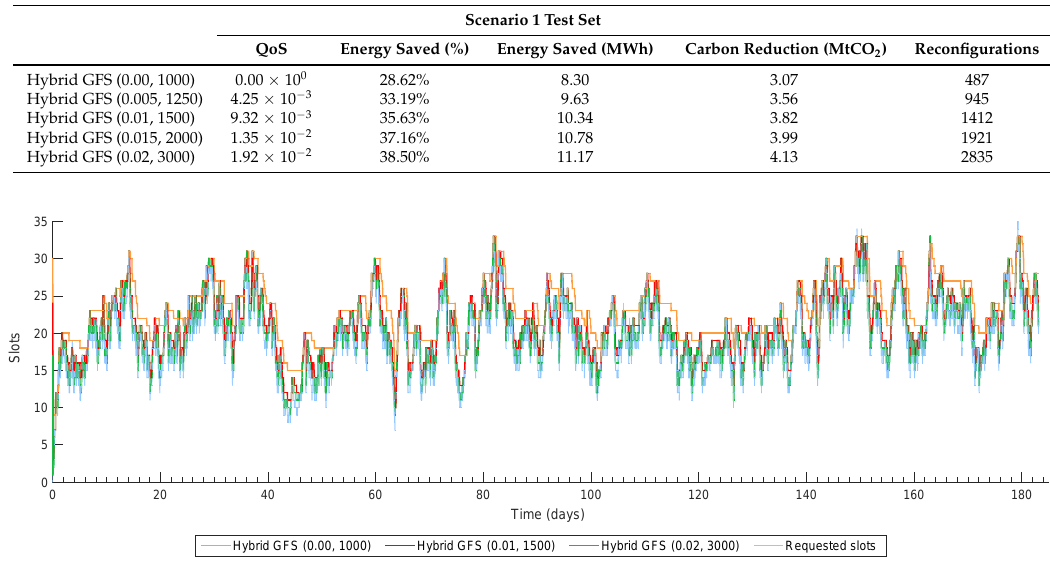
Figure 4. Cluster simulation trace for the test set of scenario 1. GFS: Genetic Fuzzy System. Table 3. Experiment results for the test set of scenario 2.